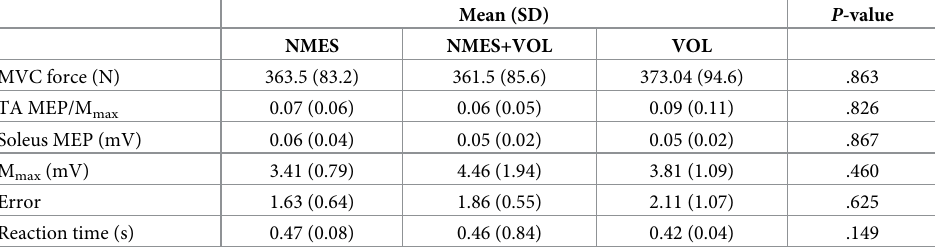
Table 1. Outcome variables at the Pre time point and results of the statistical comparison between the